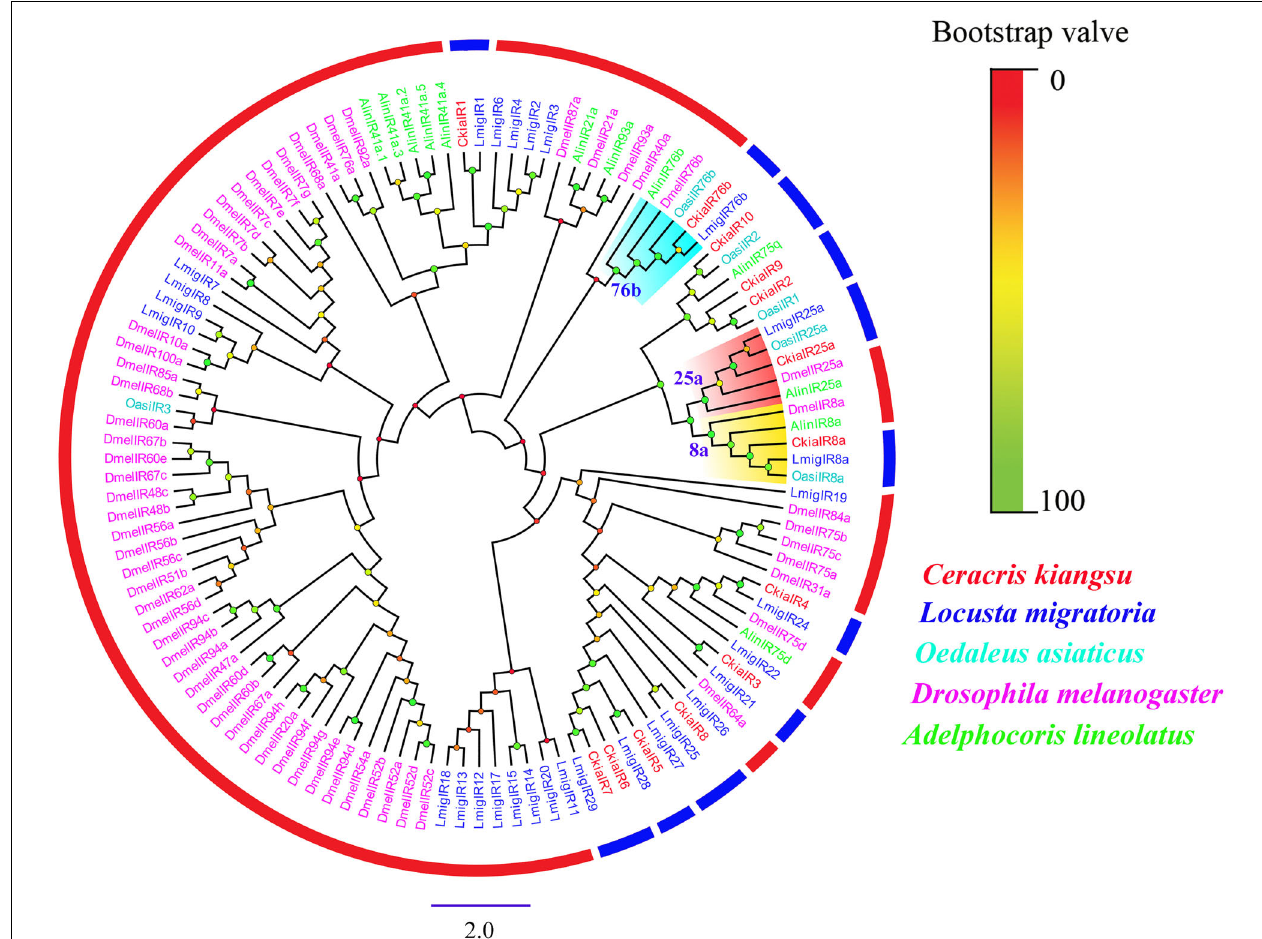
FIGURE 3 | Phylogenetic tree of putative ionotropic receptors (IRs) from C. kiangsu and other insects. Branch support (circles at the branch nodes) was estimated using bootstrap values based on the scale indicated on the top right.